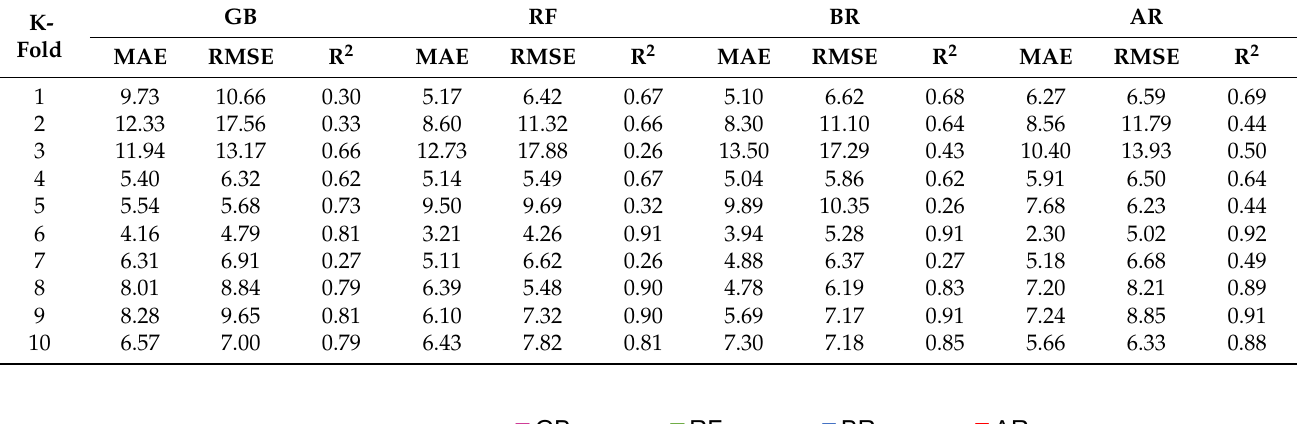
Table 2. Statistical evaluation of the techniques used.